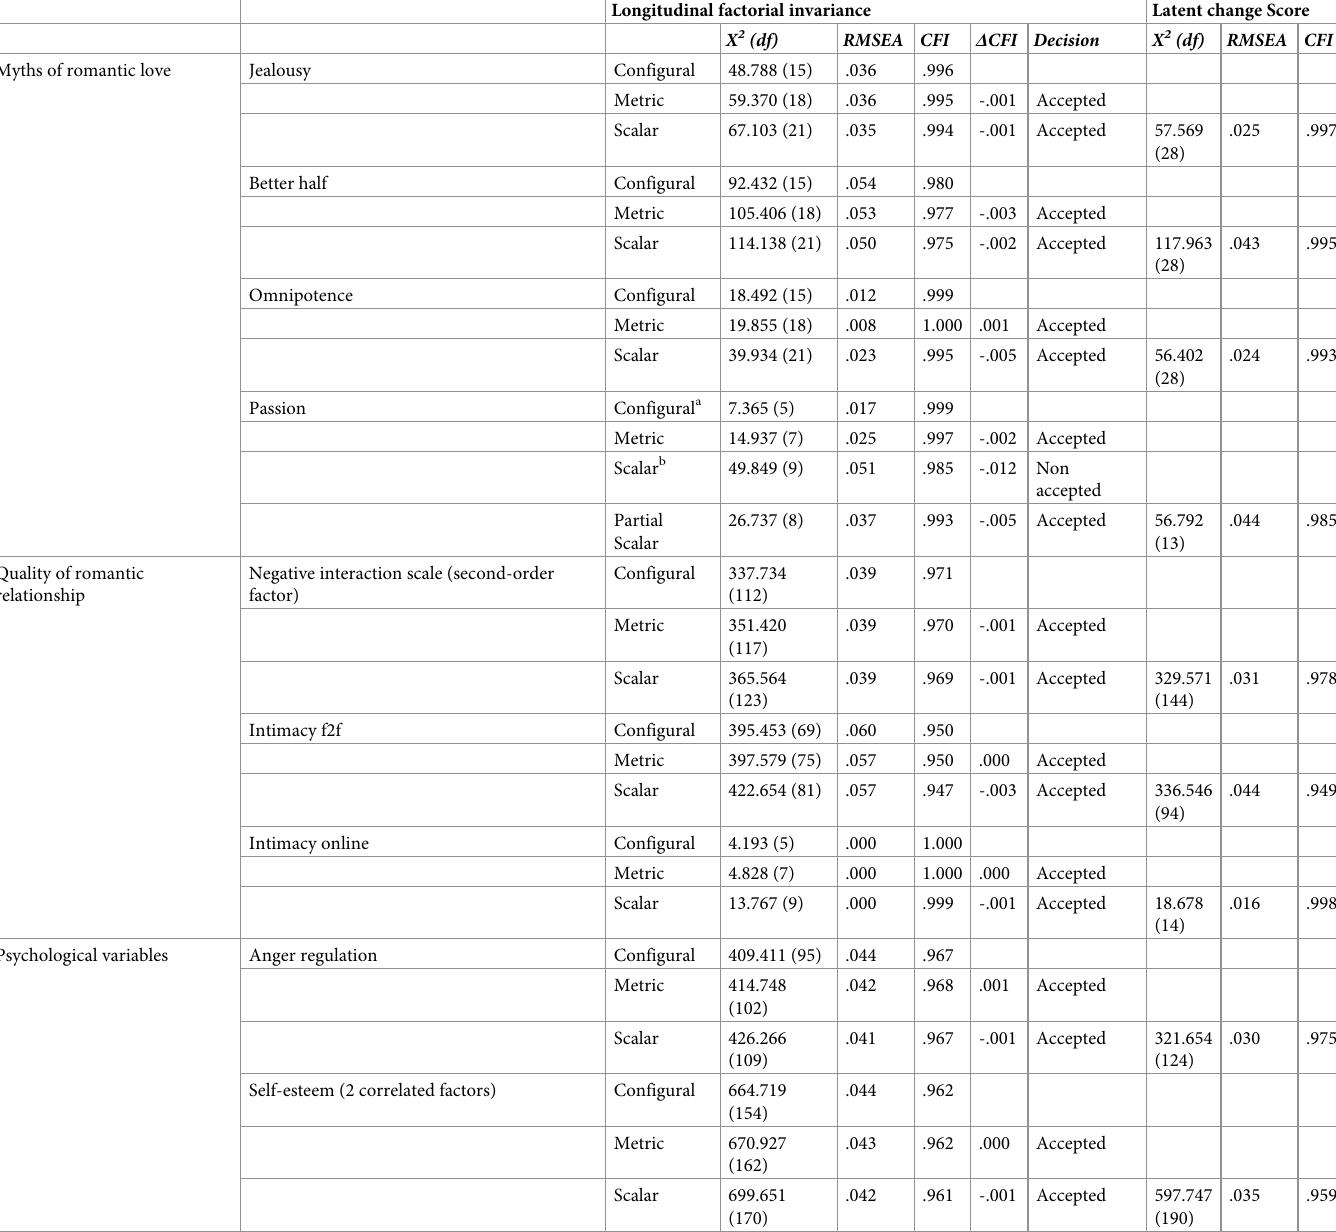
Table 4. Models fit for longitudinal factorial invariance and latent change score models for myths of love, quality of relationship, anger management and self-